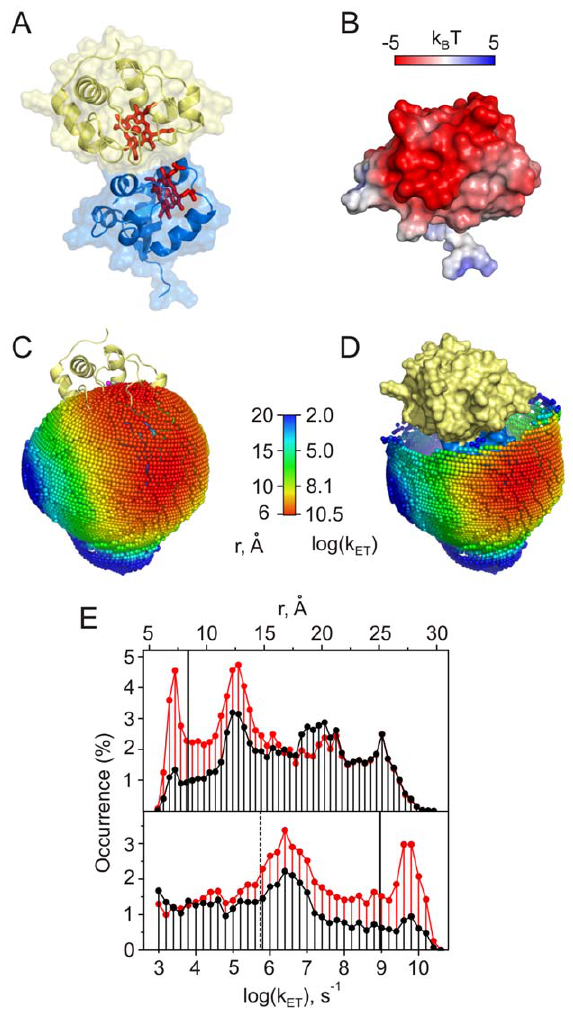
Figure 6. Cc-Cb 5 . (A) The hypothetical structural model of Salemme [5]. Cc and Cb 5 are in yellow and blue, respectively, with heme groups shown as red sticks. (B) The molecular surface of Cb 5 colored by the electrostatic potential (see the scale bar). Protein orientation is the same as in (A). (C), (D) Distribution of Cc CMs around Cb 5 in the binary (C) and ternary (D) complexes colored by the heme-heme distances or the corresponding ET rates (see the scale bar). Protein orientation is the same as in (A). Cc in the Salemme model is shown as yellow cartoon (C) or molecular surface (D). See Videos S5 and S6 for an expanded view of (C) and (D), respectively. (E) Distributions of the intermolecular heme- heme distances (top) and ET rates (bottom). Red and black traces are the distributions for the binary and ternary complexes, respectively. Solid vertical lines indicate the heme-heme distance (top) and the corresponding ET rate (bottom) in the hypothetical model of Salemme [5]. The dashed line denotes the largest experimentally measured ET rate in the Cc-Cb 5 complex [16].